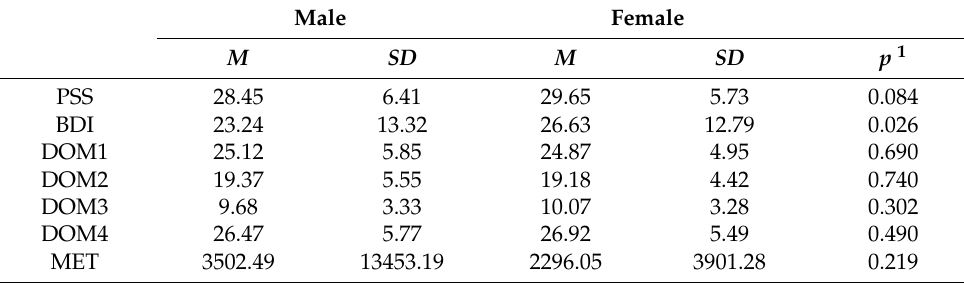
Table 4 presents the Spearman’s correlation coefficient between the outcome variables.